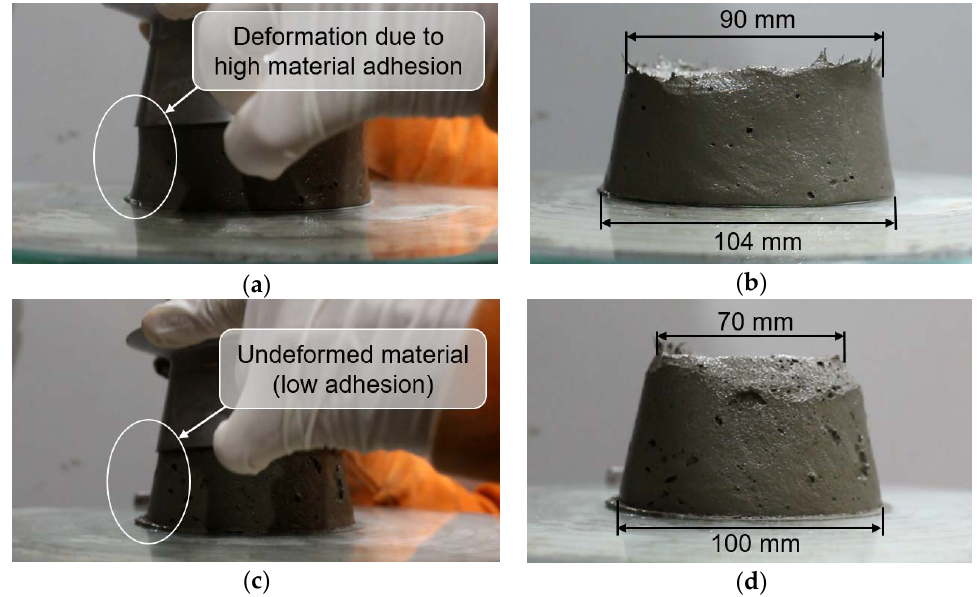
Figure 9. Flow table test; mixture Ref ( a ) during and ( b ) after leveling the form, and mixture SE-CE ( c ) during and ( d ) after leveling the form.